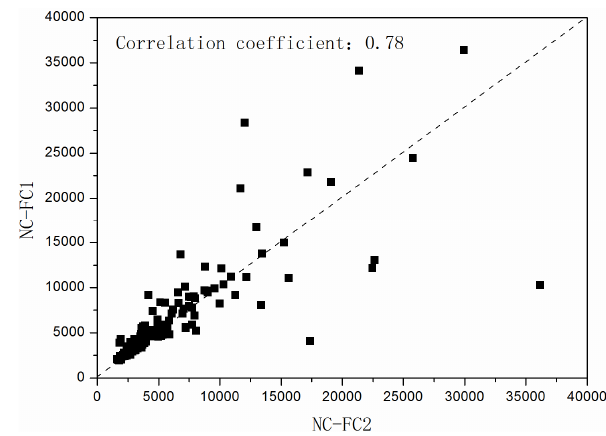
Fig. 8. Comparison of DOM-Vis results obtained with different dis- Figure 8. Comparison of DOM-Vis results obtained with different distances between the 498 tances between the near and far near and far cameras. 499